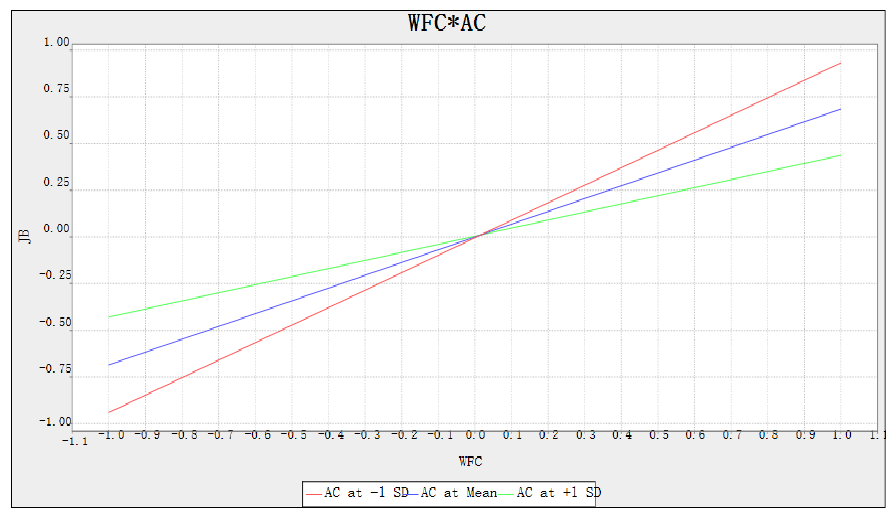
Figure 4. Moderating effect of affective commitment. Note: AC, affective commitment. JB, job burnout.